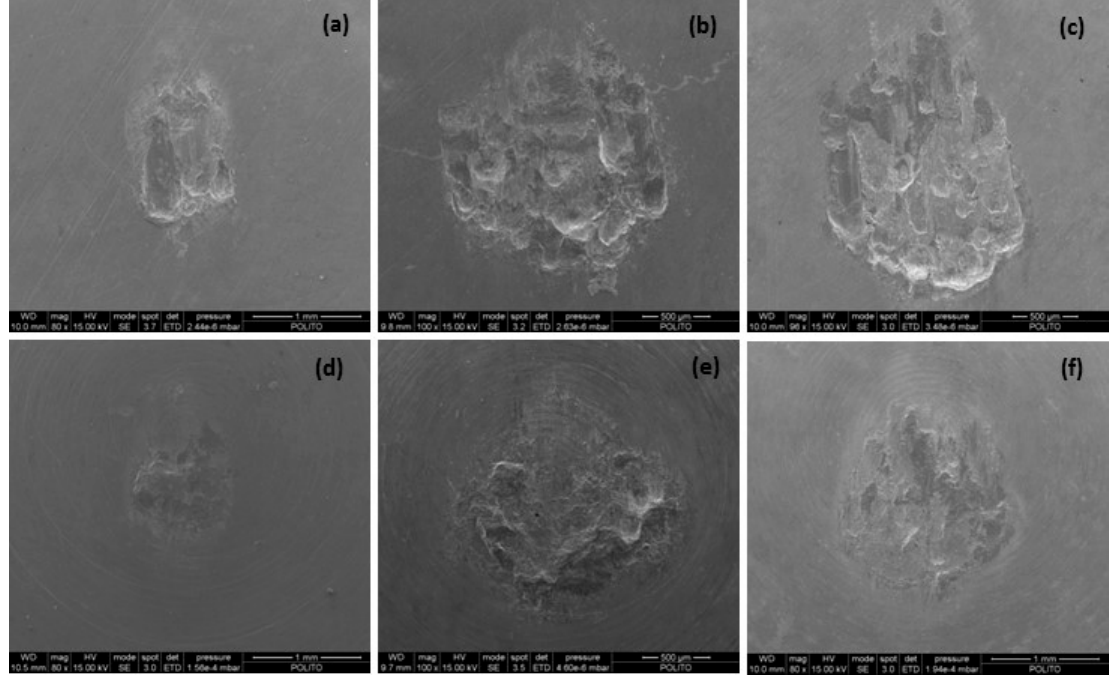
Figure 12. damage at the end of the wear process: ( a ) pair 02—flat; ( b ) pair 02—spherical; ( c ) pair 03—flat; ( d ) pair 03—spherical; ( e ) pair 05—flat; ( f ) pair 05—spherical; ( g ) pair 07—flat; ( h ) pair 07—spherical.